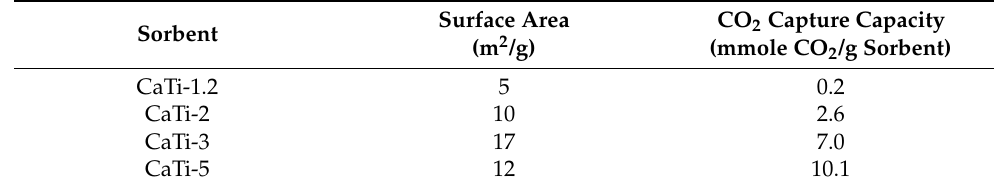
Table 1. Surface area and CO 2 capture capacity of calcium-based sorbents.